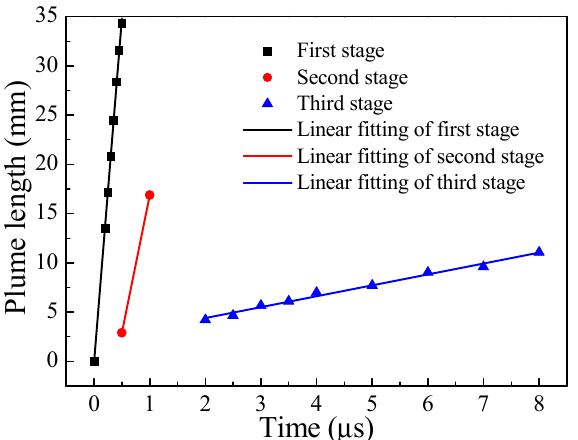
Figure 6. The plasma length of three stages changes with time at ambient pressure 0.005 Pa and laser energy 542.3 mJ.